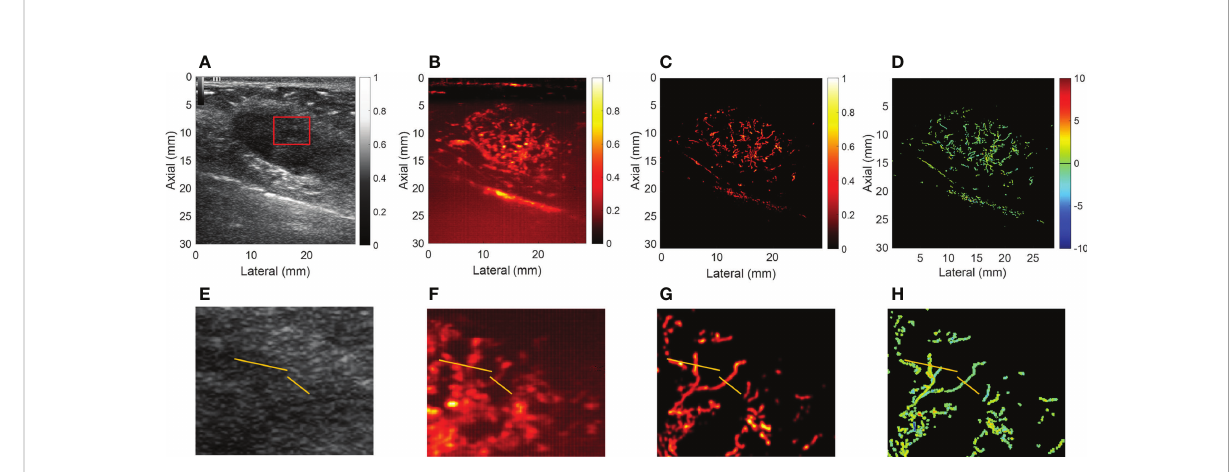
FIGURE 3 Ultrasound images of a representative benign breast mass. (A) B-mode image. (B) Contrast-enhanced ultrasound image. (C) Super-resolution image. (D) Super-resolved velocity image. (E – H) Shows the zoomed-in regions of (A – D) as the red box indicated in (A) . Yellow lines in (E – H) highlight the resolution improvement among the images.